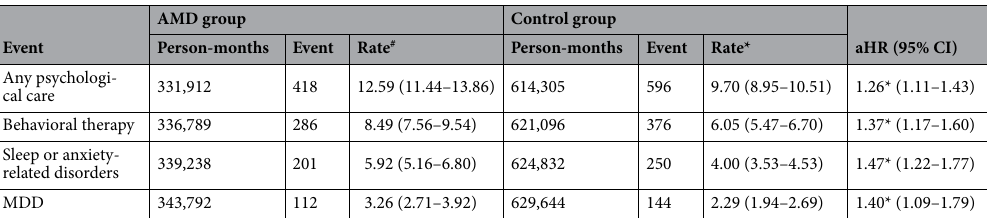
Table 2. Study events in the study and control groups. AMD age-related macular degeneration, aHR adjusted hazard ratio adjusted for age, sex, education, marital status, and comorbidities, CI confidential interval, MDD major depression disorder. *Significant difference. # Crude incidence rate per 10,000 person months.